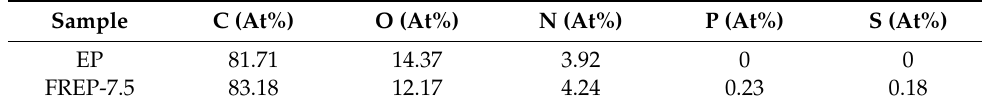
Figure 8. C1s ( a ), N1s ( b ), O1s ( c ), and P2p ( d ) spectra of residual char of FREP-7.5. 3.8. Raman Characterization of the Char Residues Raman spectroscopy can be applied to characterize the degree of graphitization of carbon materials. Figure 9 plots the Raman spectra of the char residue of pure EP and FREPs. The spectra of all samples have two peaks belonging to the D-band (around 1360 cm −1 ) and the G-band (around 1600 cm −1 ), which represent disordered carbon and graph- itized carbon, respectively [40]. The value of A D /A G (area ratio of D-band to G-band) can reflect the graphitization degree of the charcoal residue, and its lower value means the higher graphitization degree of the corresponding char layer. The A D /A G values of the char residues from pure EP, FREP-5, FREP-7.5, and FREP-10 were determined to be 2.57, 2.50, 2.30, and 2.11, respectively. It can be seen that the values of FREPs are all lower than that of the pure EP, and the lowest value is achieved for FREP-10, indicating that the addition of AVD enhanced the graphitization of the char layer, which facilitates the formation of a denser and continuous char layer that acts as a barrier to inhibit the further degradation of the substrate.